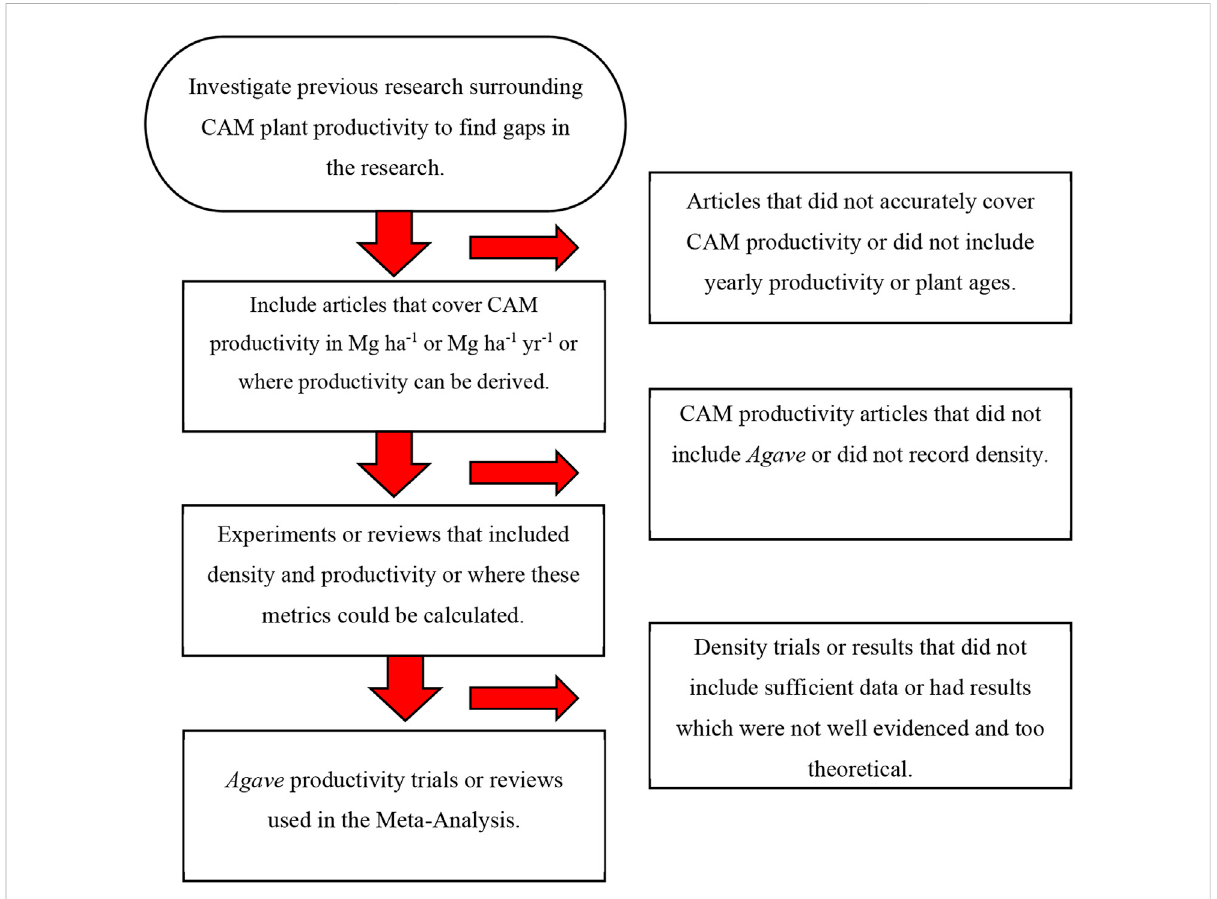
FIGURE 2 Flowchart showing the research process, sorting through relevant articles to fi nd relevant and reliable